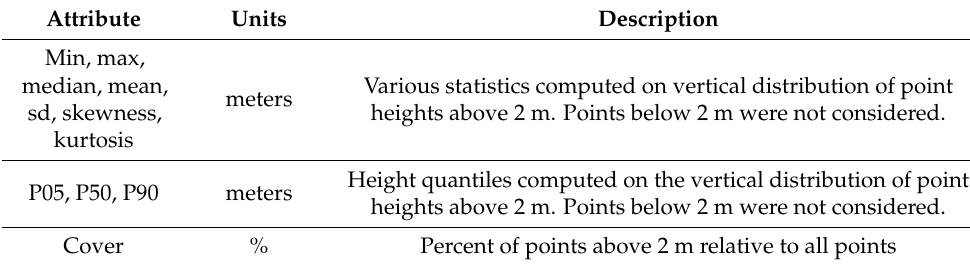
Table 5. Example DAP height metrics computed using